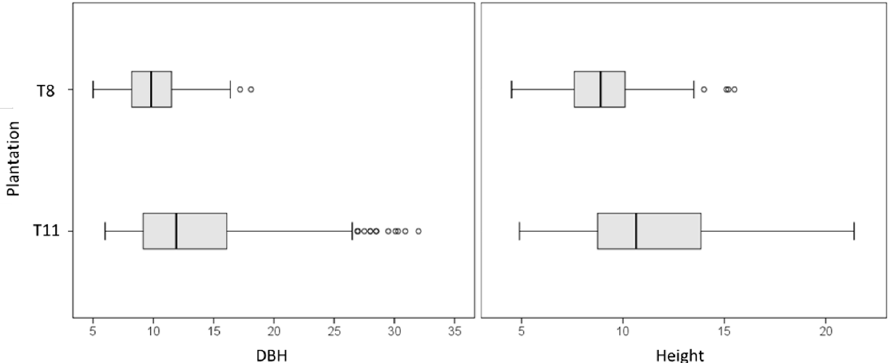
Figure 2. Box plots showing the comparison of the distributions of diameter at breast height (DBH) (cm) and height (m) in plantations T8 and T11. Table 2. Dendrometric and productive characteristics of the T8 and T11 plantations (±SD in brackets).